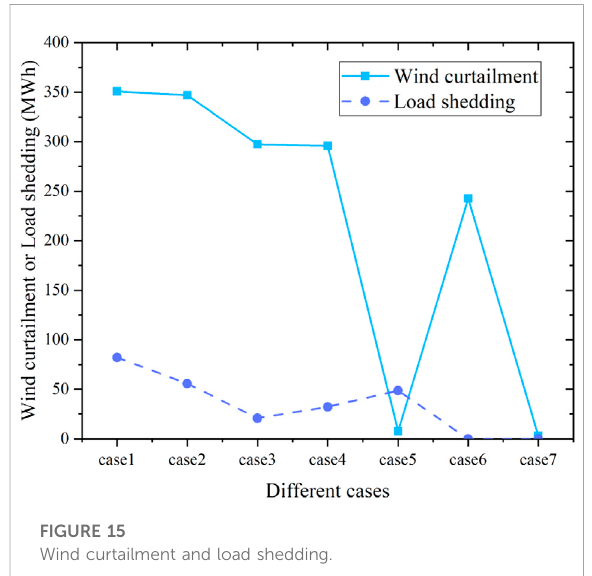
FIGURE 15 Wind curtailment and load shedding.